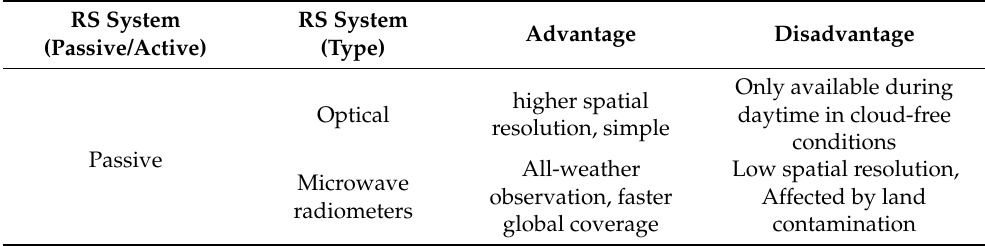
Table 4. Different RS systems for OSS estimation along with their advantages and